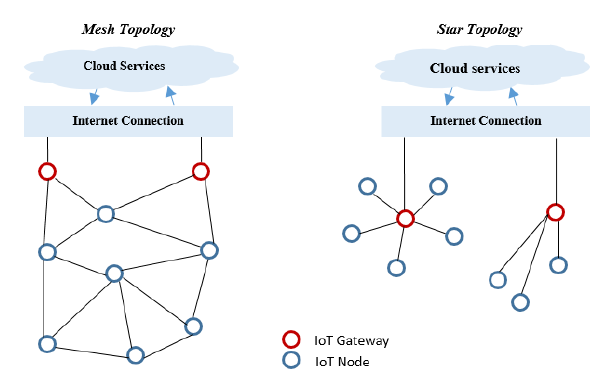
Figure 7. IoT mesh and star network